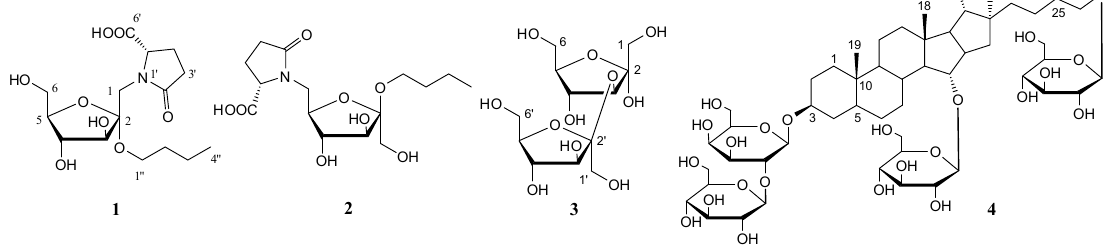
Figure 1. Structures of compounds 1 – 4 from Anemarrhena asphodeloides .